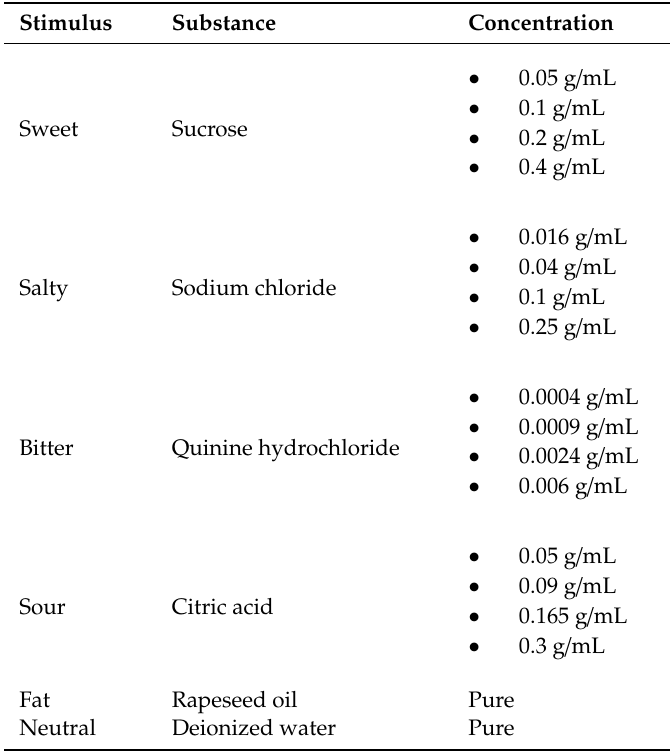
Table 1. Concentrations of taste